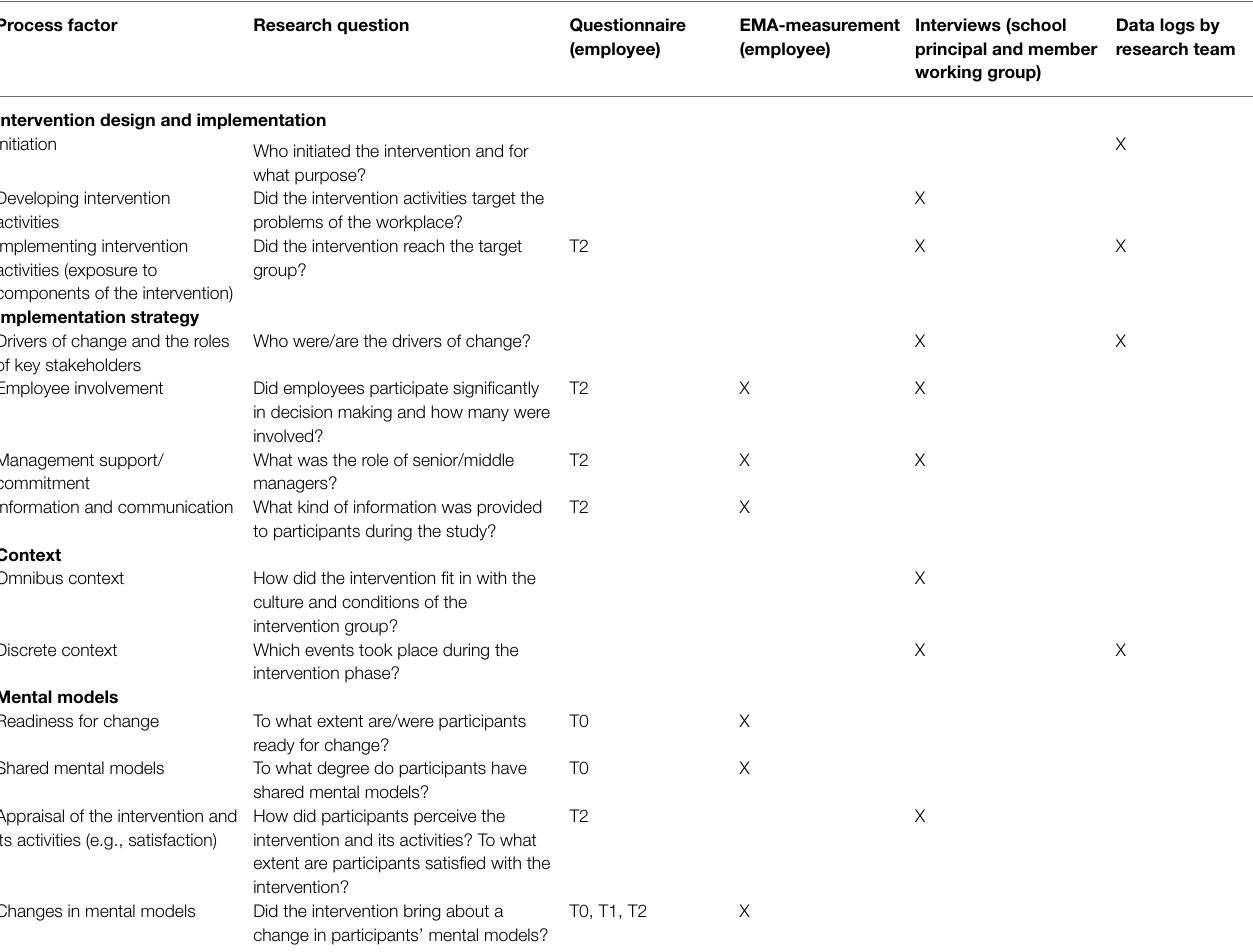
TABLE 1 | Process factors and type of data